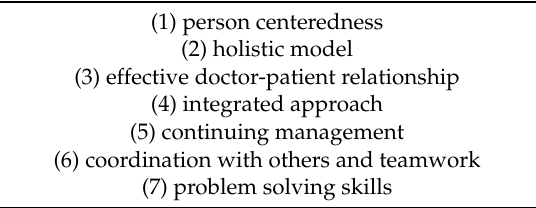
Table 3. Tools used by GPs to manage the difficulties and challenges of multimorbidity.